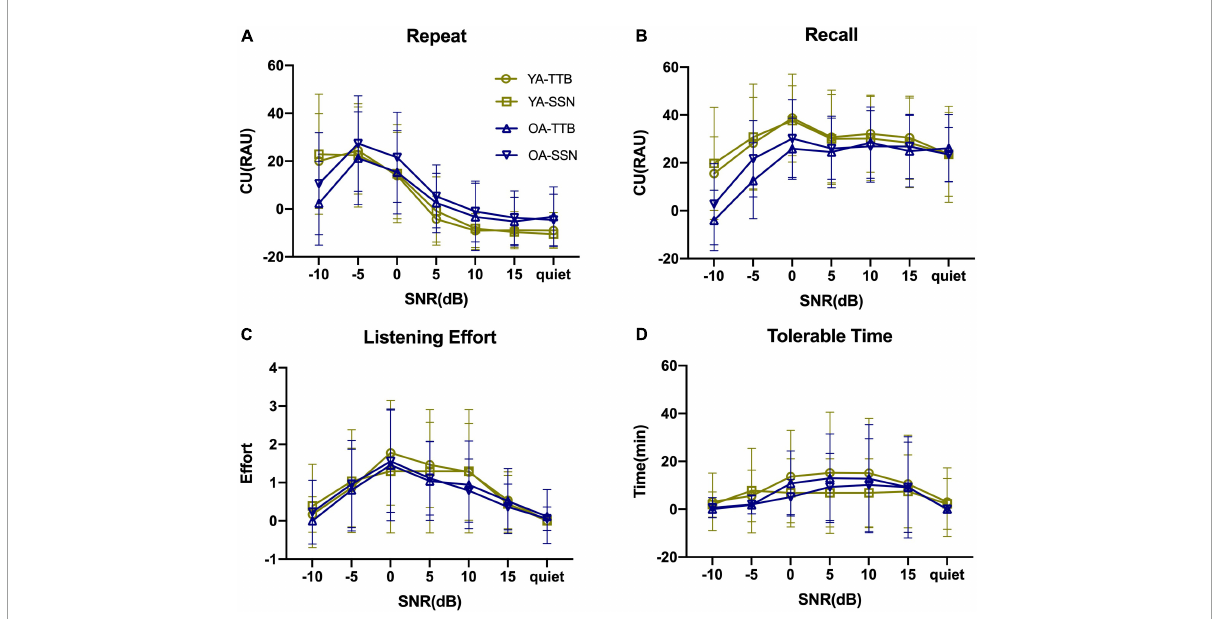
FIGURE2 Context use (CU) of two age groups under two noise conditions and seven SNRs. (A) As for CU (Repeat), both age groups increased as SNR becomes worse and OA finally decreased when SNR = –10 dB, where YA could still hold the utilization of context. (B) As for CU (Recall), both age groups maintained their utilization of context when SNR > –5 dB and started to decrease at SNR = –5 and –10 dB. (C) As for CU (LE), LE was alleviated by context, and such alleviation arose as SNR became worse, peaking at SNR = 0 dB, and then decreased. (D) As for CU(TT), it seemed that it had a more stable trend as SNR changed. Error bars represented one standard